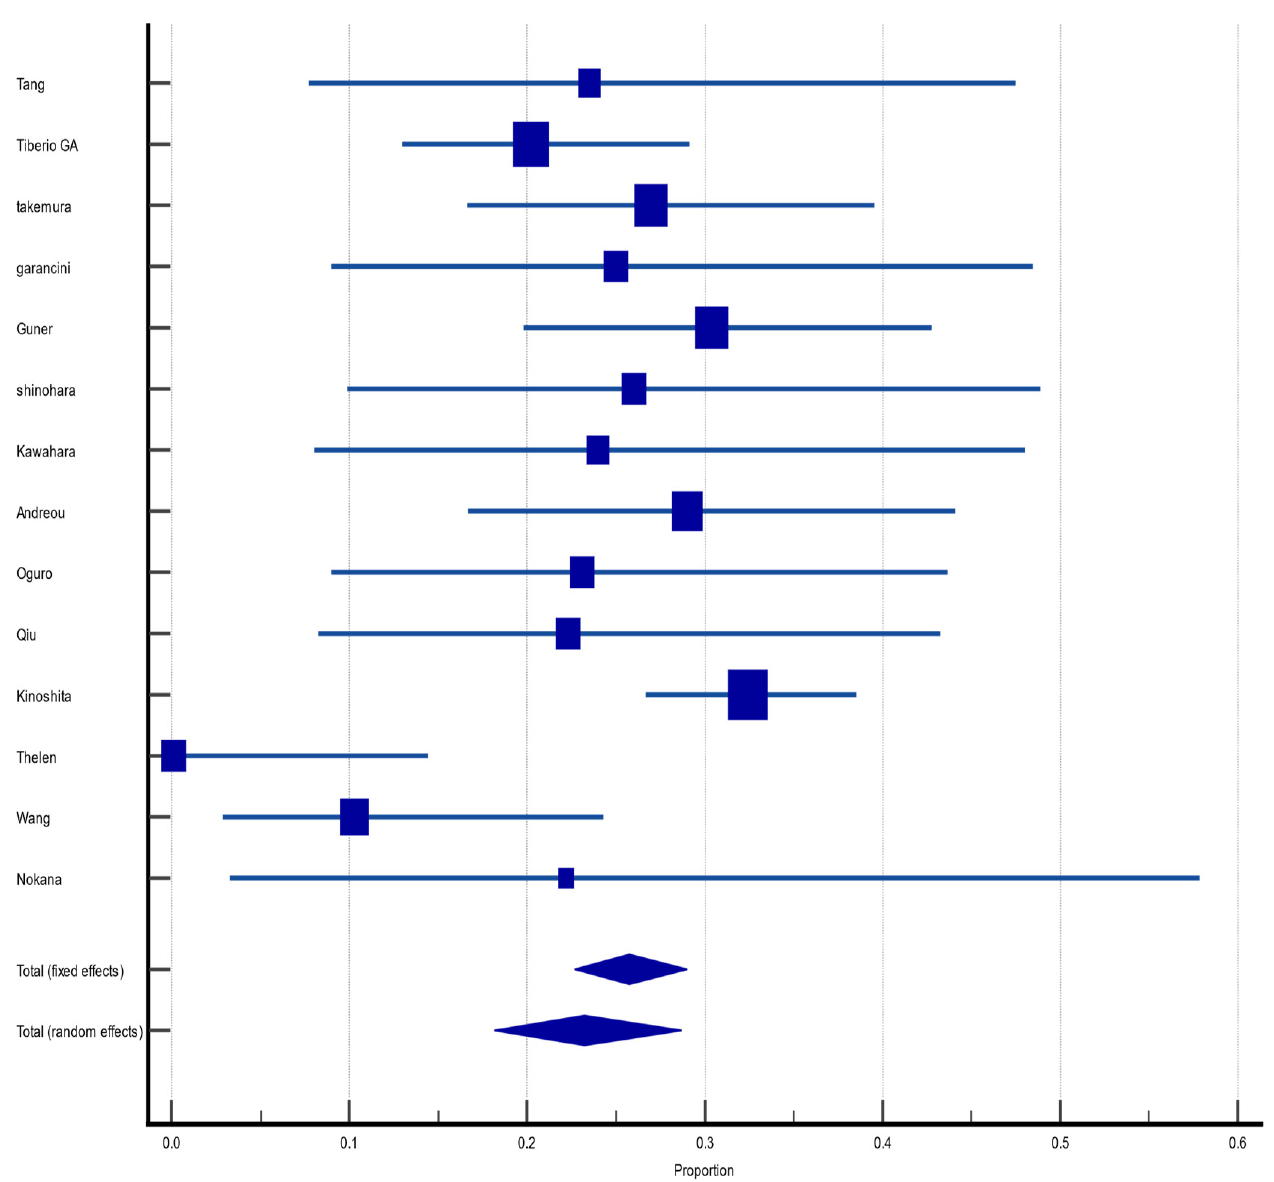
Figure 6. Forest plot of disease-free survival at 3 years after hepatectomy for gastric cancer liver metastasis (GCLM). Description of the proportion and confidence intervals at 95% in the studies that reported 3-year disease-free survival.